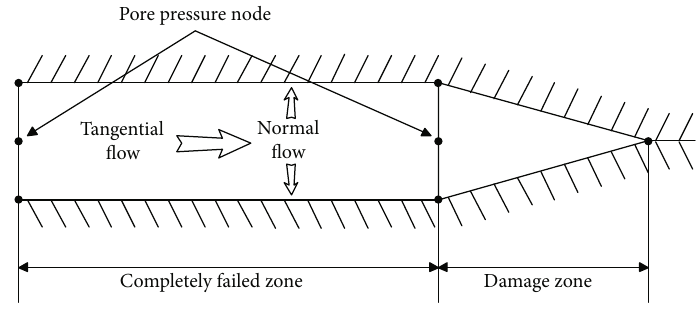
Figure 3: Sketch of fl uid fl ow within cohesive